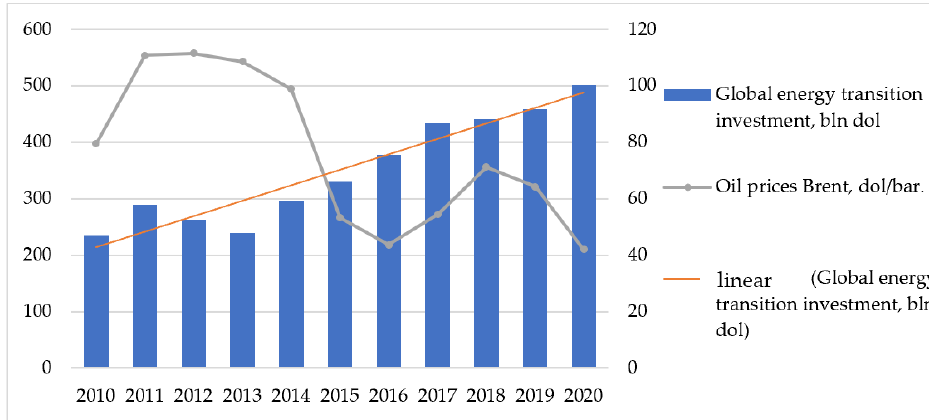
Figure 3. Changes in oil prices and total investments in the global energy transition. Source: compiled by the authors based on [45,46].